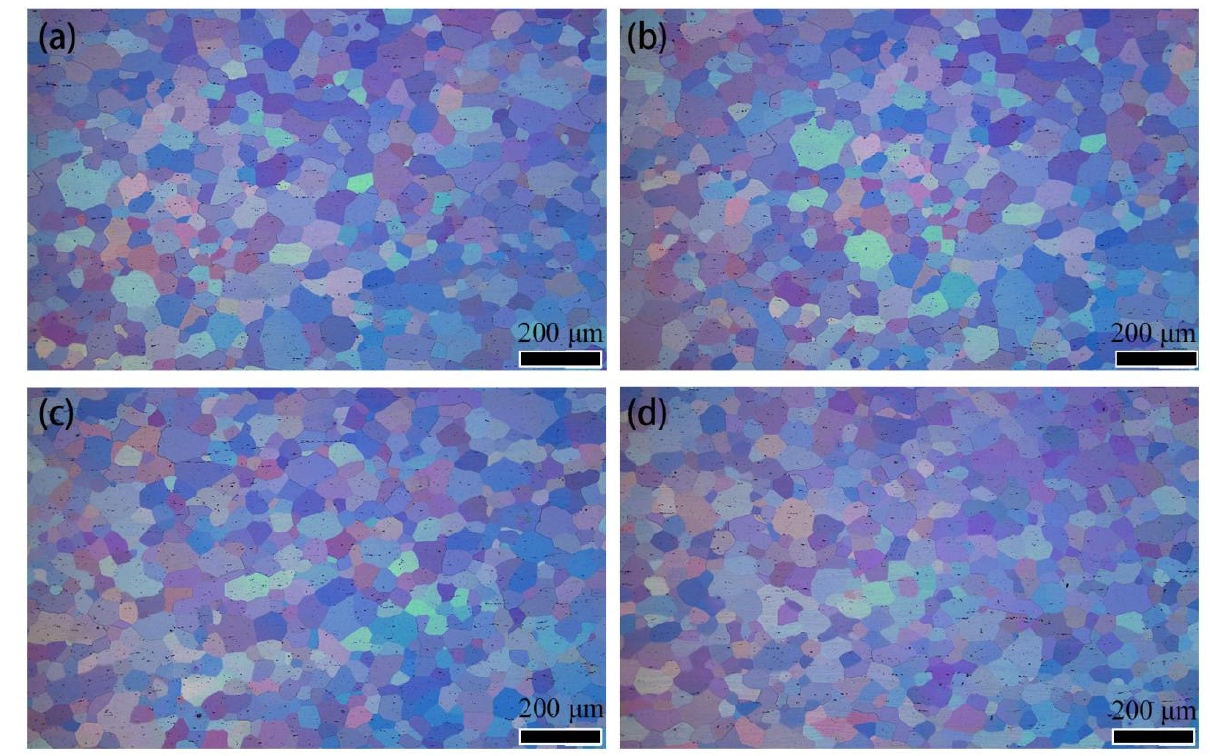
Figure 4. Grain structure of quenched Al-(2.86~9.41) Mg alloy sheet ( a ) x = 2.86%; ( b ) x = 4.23%; ( c ) x = 6.51%; ( d ) x = 9.41%.